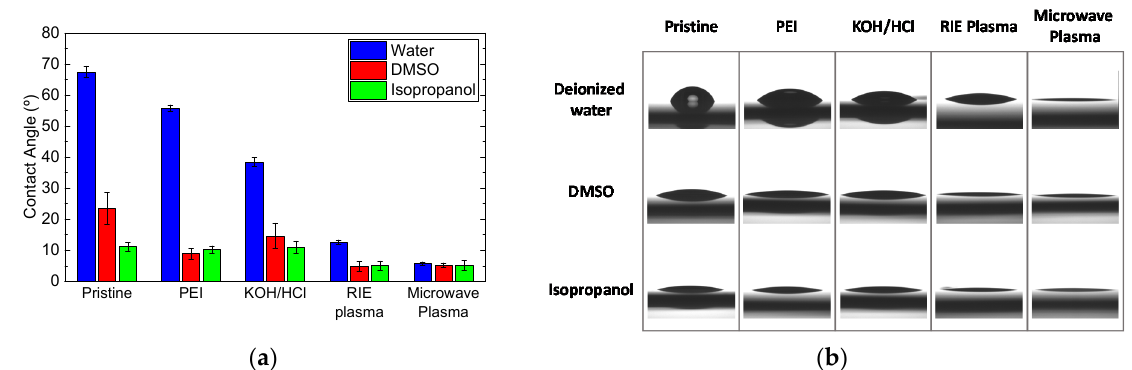
Figure A1. Contact angle of PI films: ( a ) Average values for three solvents on pristine and treated films; ( b ) Example of solvent drops on PI films.